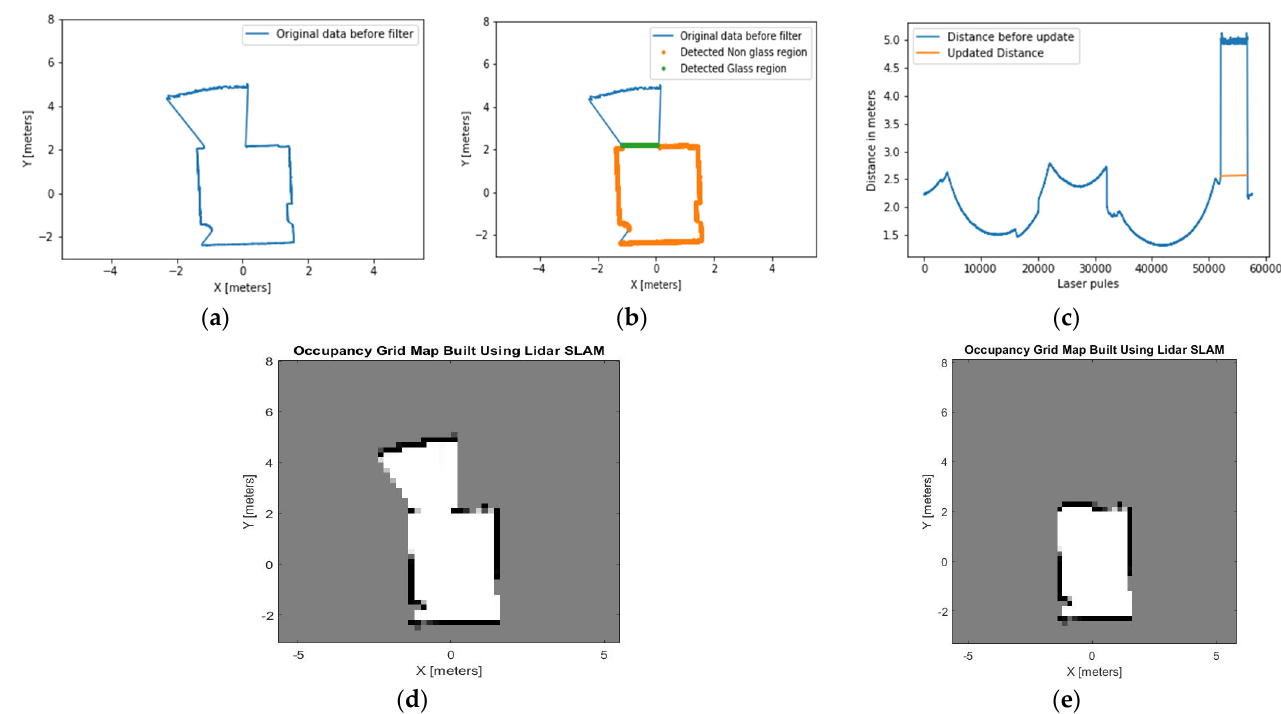
Figure 12. ( a ) A map built by the original LiDAR data shows no recognition of the presence of glass in the empty room, ( b ) the glass region is detected and presented in a green dotted line, ( c ) the distance measurement is updated based on the detected glass region and presented in the orange line, ( d ) the occupancy grid map built by using the original LiDAR data before the glass region is detected. This map shows area beyond the glass region as a free space, ( e ) the occupancy grid map built using the proposed method recognises the area beyond the glass as occupied spaces.